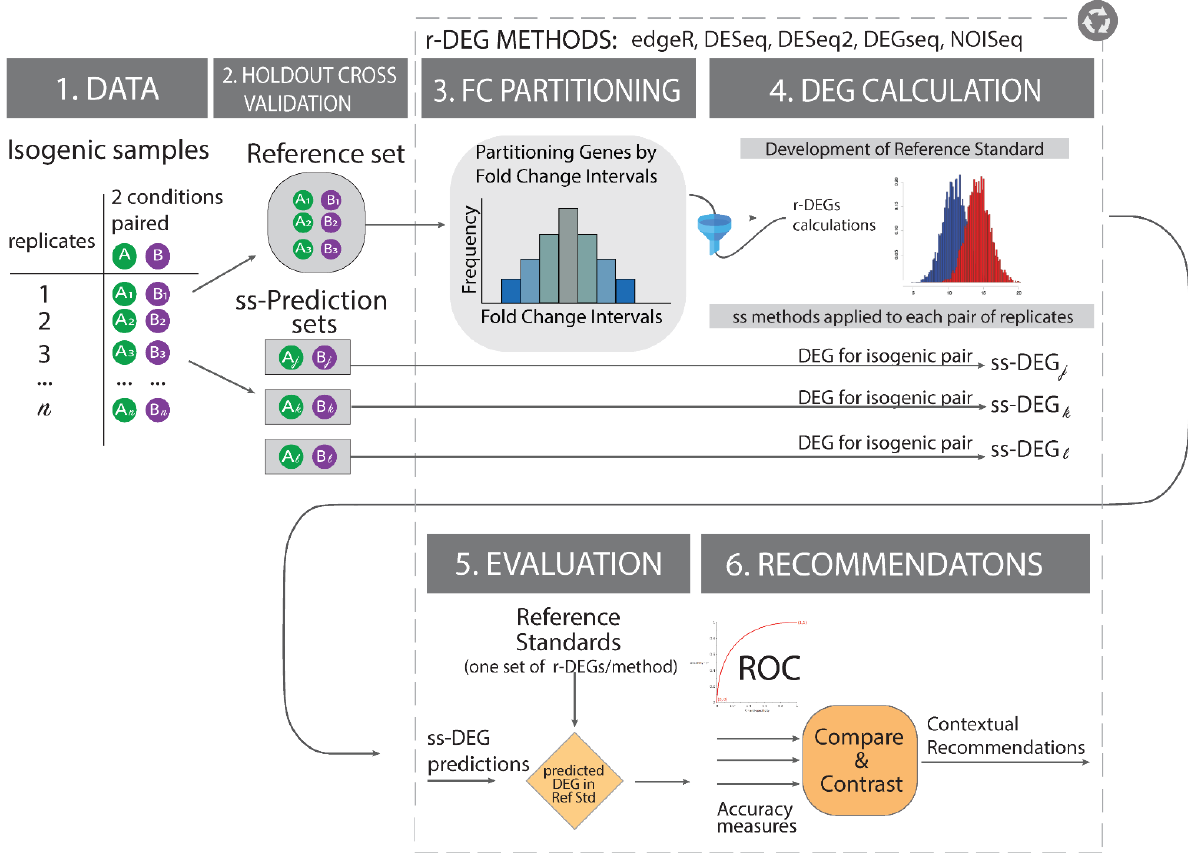
Figure 1. Reference Standard Construction Study Overview. In isogenic paired samples from historical cell lines datasets exposed to two conditions (condition A in green and B in purple), we first split the paired stimulus-control data into non- overlapping reference and prediction sets. To maximize biological interpretability and relevance, we run all differentially expressed genes (DEG) calculations and organize the results by fold change regions and conduct all evaluations. We introduce the effect-size (Fold change) analysis into the study to mitigate noisy results (i.e., low p-values with negligible effect sizes) while maximizing biological interpretability and quantify this improvement via accuracy measures (i.e., Area under the ROC curve) on an exemplar study. Notation: ss = single-subject, ss-DEG i = differentially expressed genes in a single subject “ i ”, conditions: A or B, A k = gene product expression of gene “ k ” in condition A; B k = gene product expression of gene “ k ” in condition